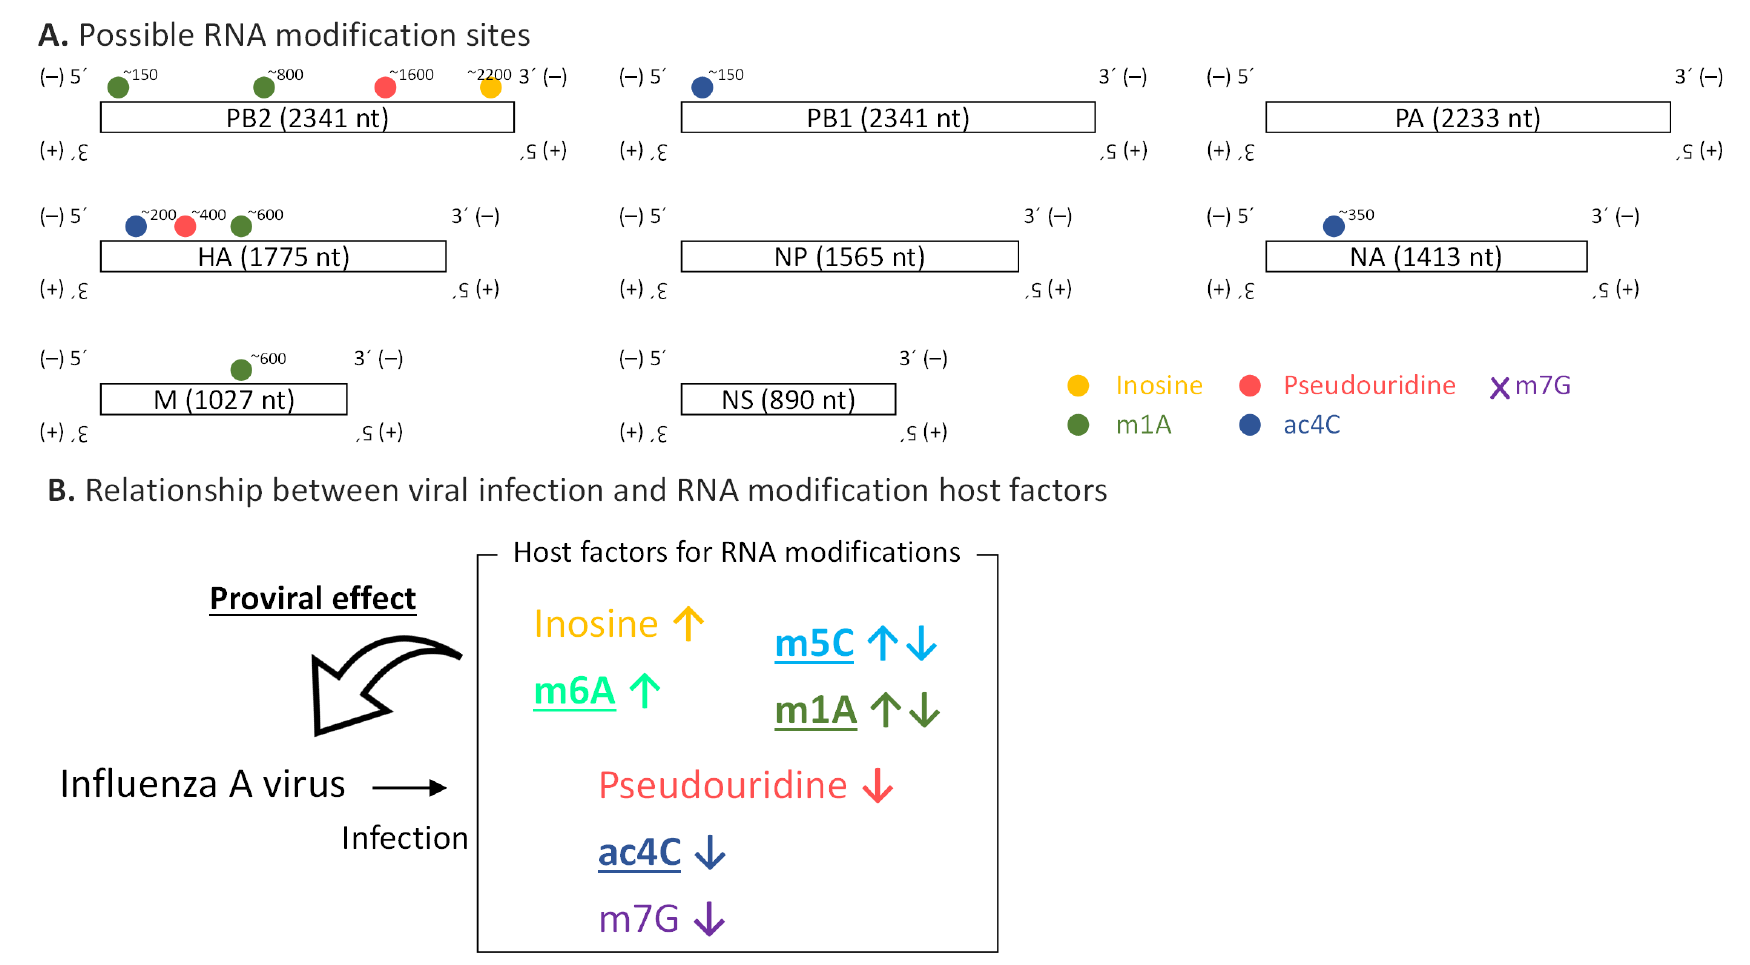
Figure 6. Summary of the relationship between RNA modifications and influenza A virus. ( A ) Catalog of possible RNA modifications and their positions in RNA derived from influenza A virus identified in the present study. m7G sites were not detected. ( B ) Relationship between viral infection and host factors for RNA modification is illustrated. Changes in expression levels ( ↑ upregulation or ↓ downregulation) of host factors by viral infection are depicted as vertical arrows next to the names of RNA modifications. Host factors related to RNA modifications described in bold characters with underline possibly have a proviral effect.